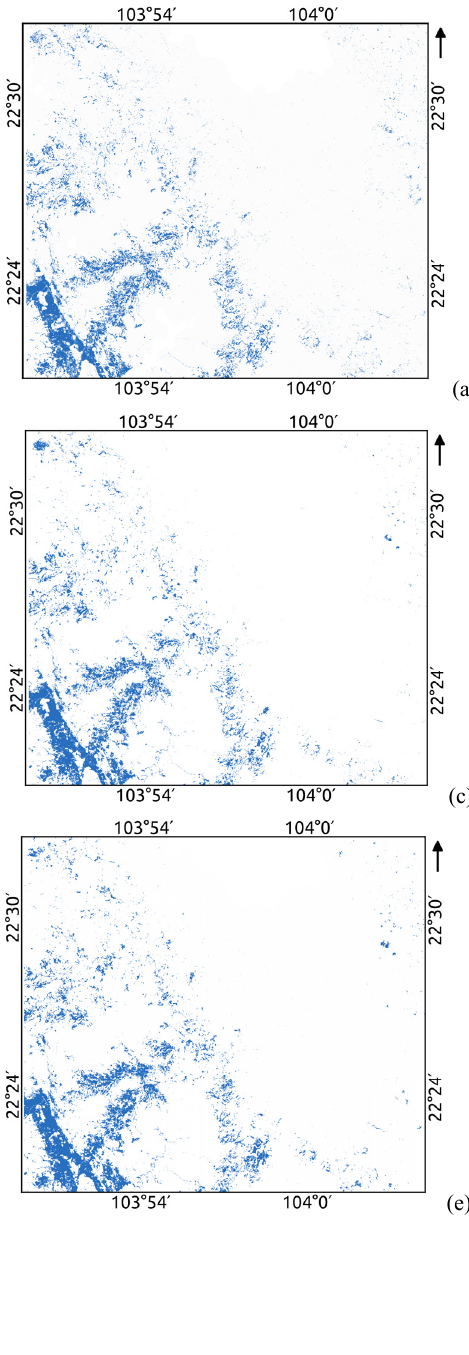
Figure 6. Result terrace field maps (a) Pixel-based Object-based: (b) T =